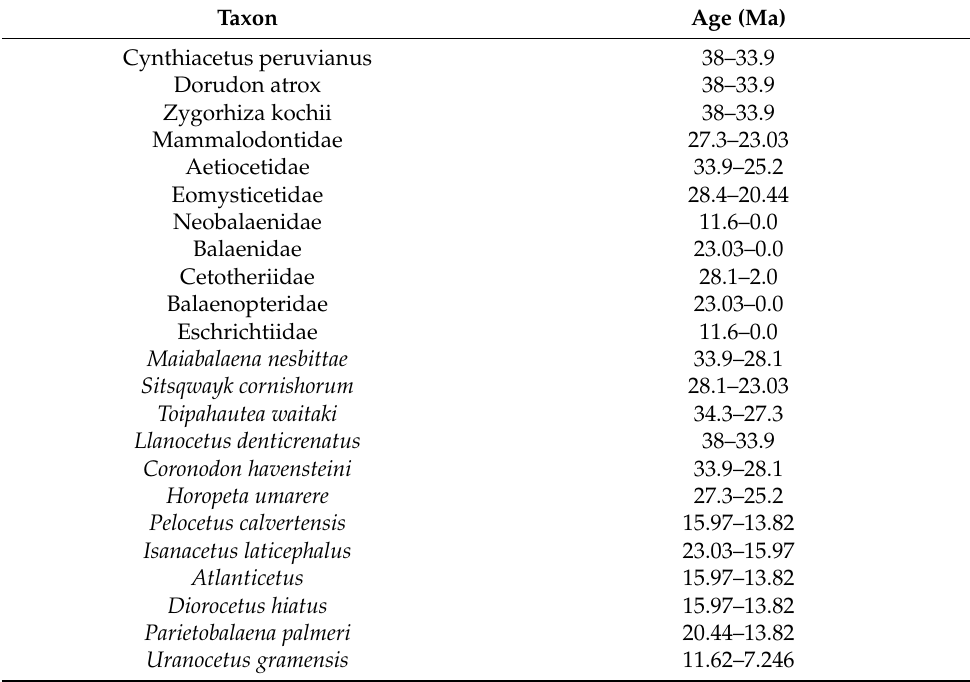
Table 1. Stratigraphic ages of the taxa used in the combined phylogeny. Data from Paleobiology Database (https://paleobiodb.org/, accessed on 23 September 2021) visited on 23 January